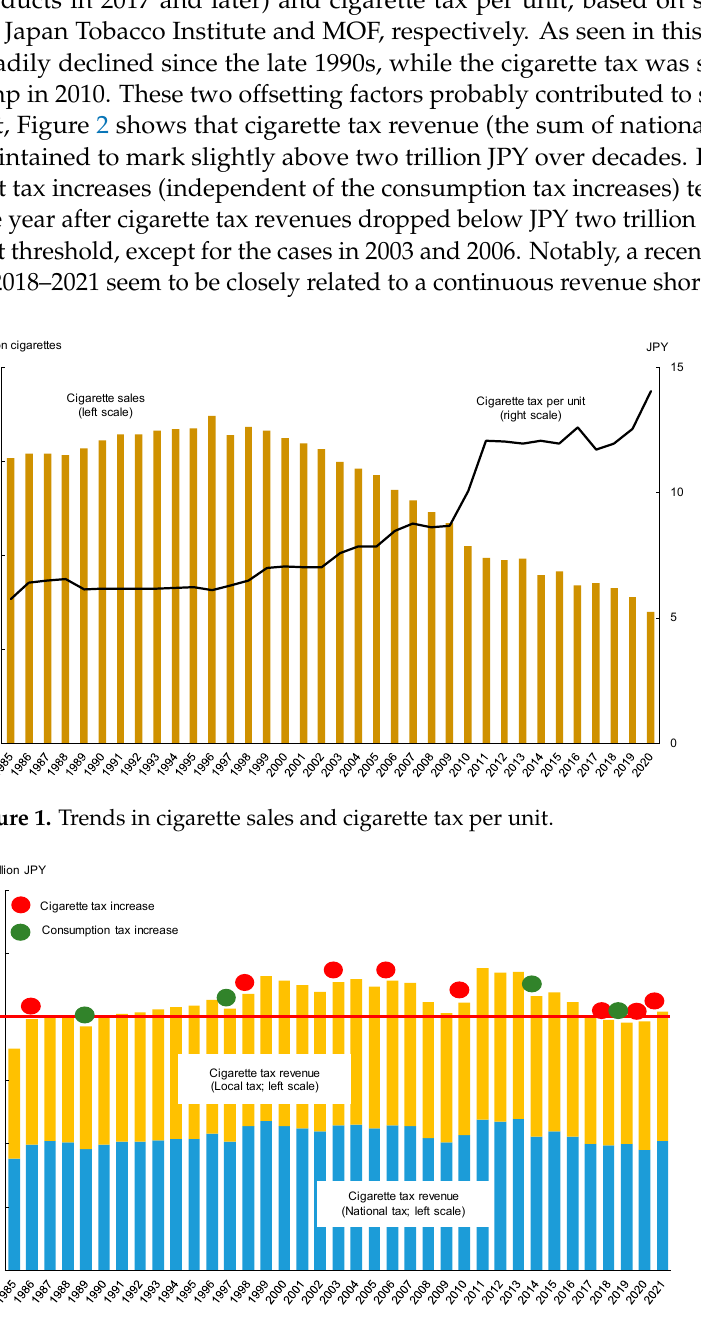
Figure 2. Trend in cigarette tax revenue and timings of cigarette tax increases.